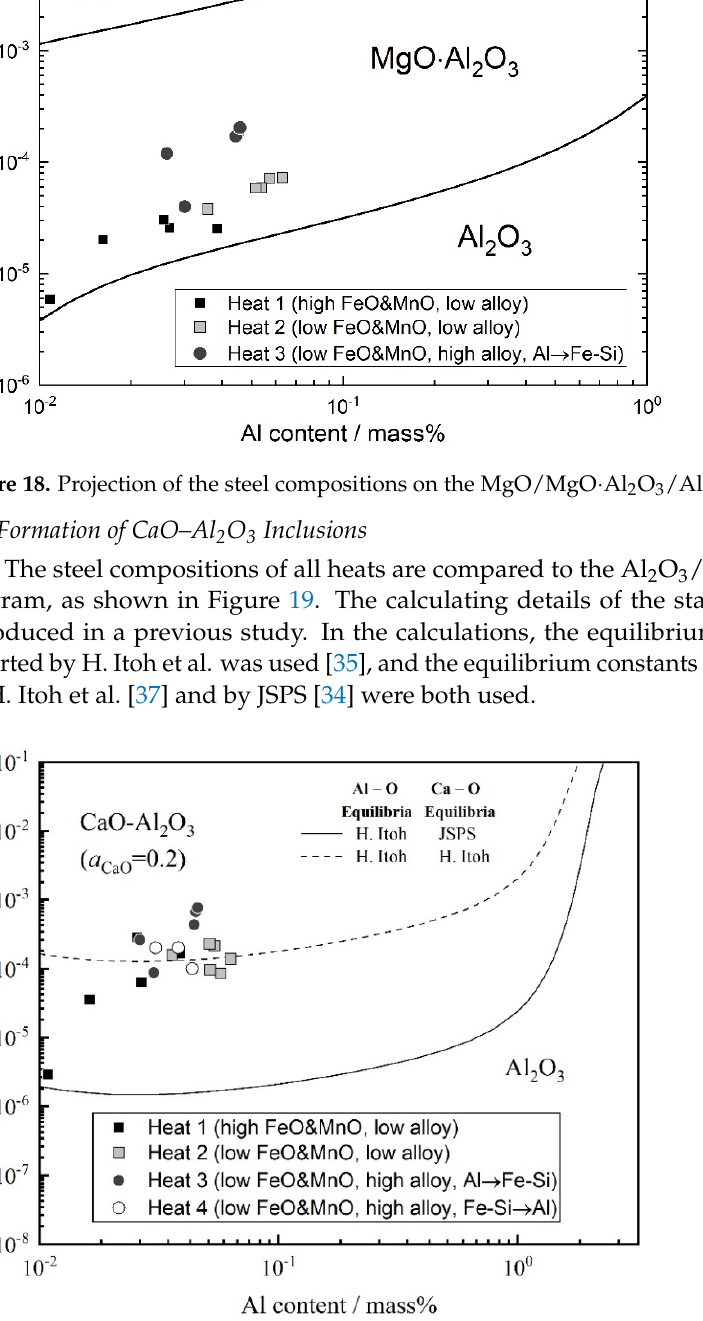
2 O 3 /CaO–Al 2 O 3 stability